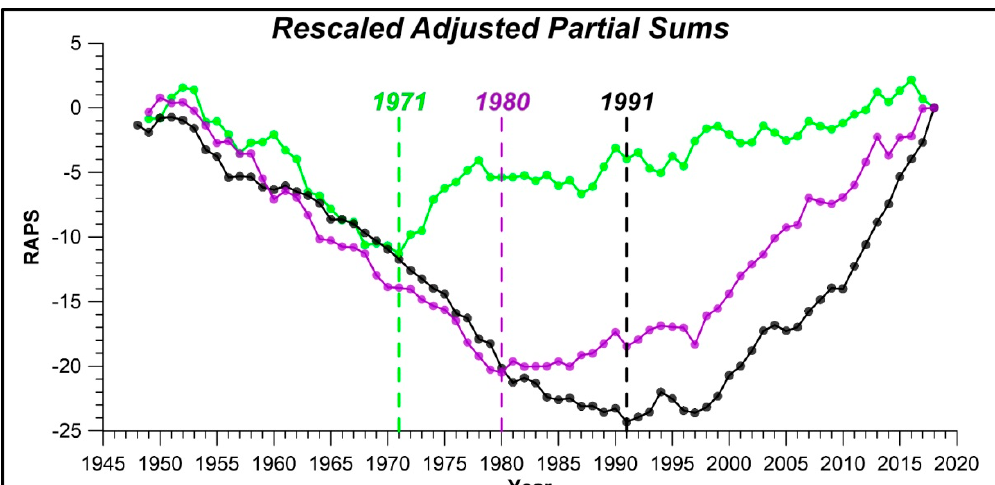
Figure 4. Rescaled Adjusted Partial Sums ( RAPS) values for the minimum (green), mean (black), and maximum (purple) annual air temperature measured at the Lastovo station.